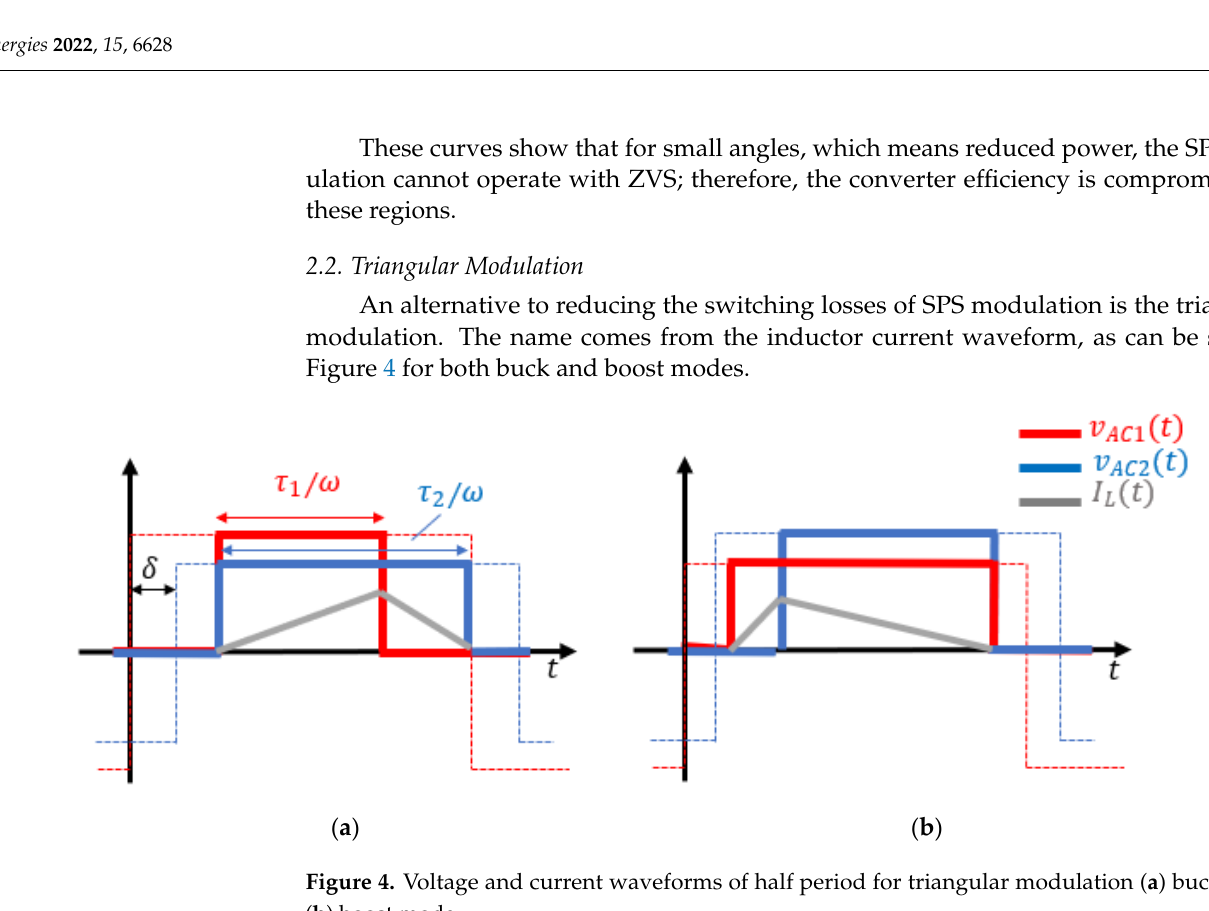
Figure 3. Power transfer curves and limit powers for ZVS operation.